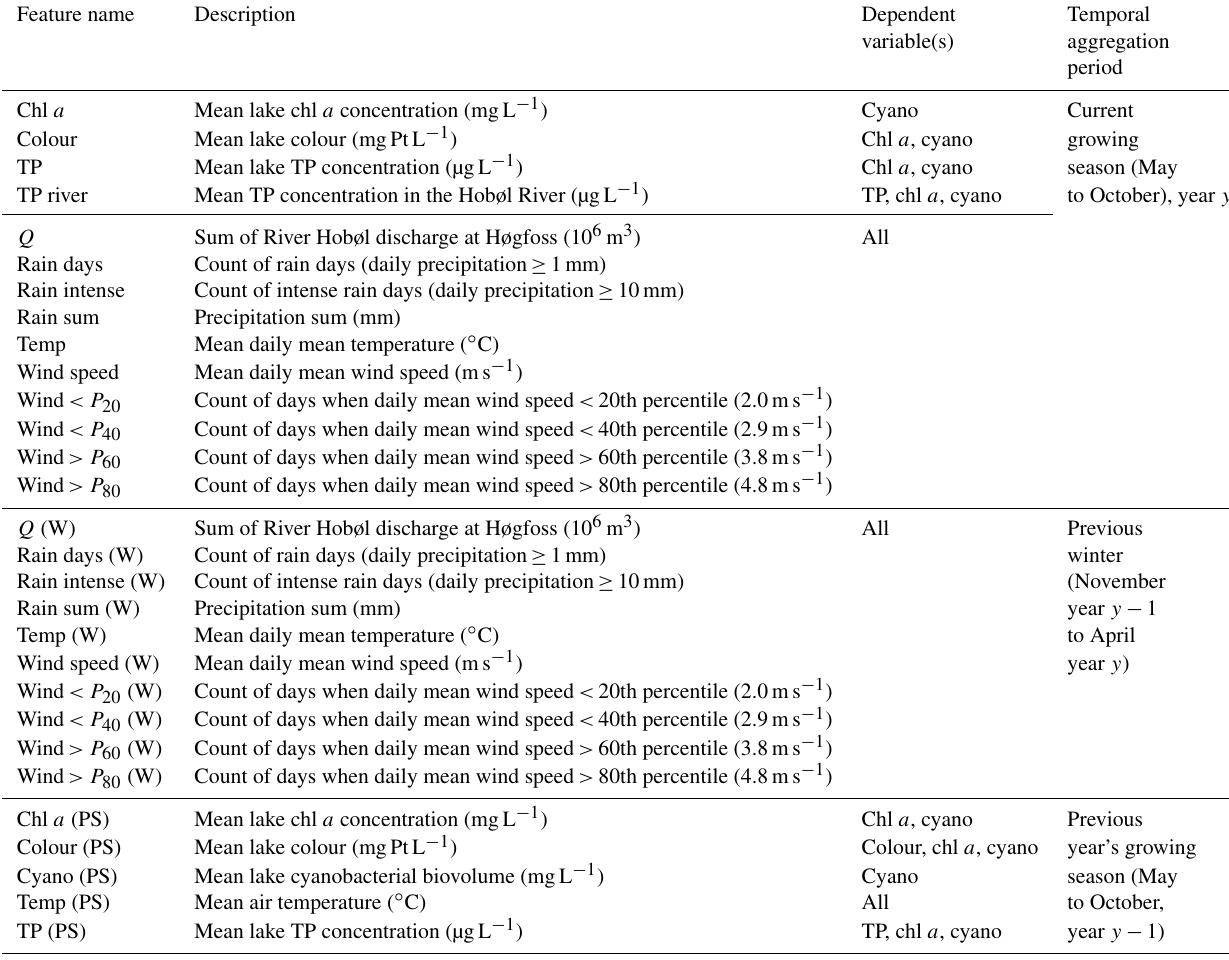
Table 1. Potential explanatory variables (features) considered for each of the four dependent variables (chl a , TP, cyanobacteria, and colour). The temporal aggregation period is given relative to the forecast issue date in spring of the current year, y